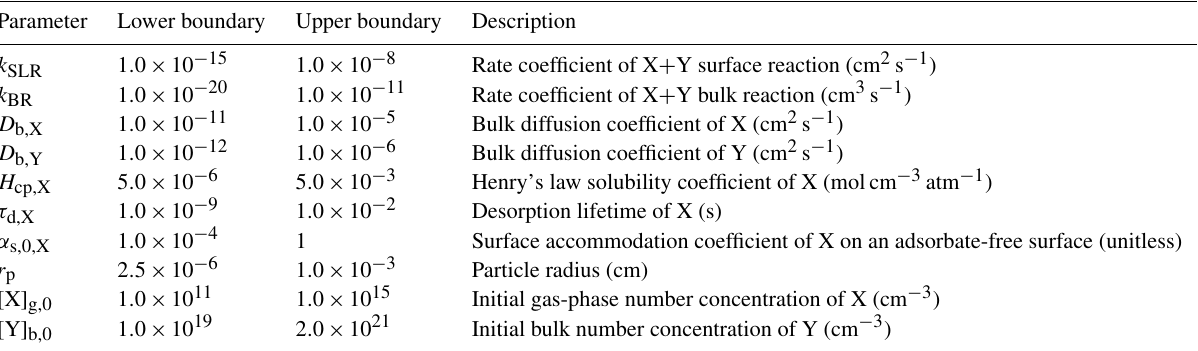
Surface accommodation coefficient of X on an adsorbate-free surface